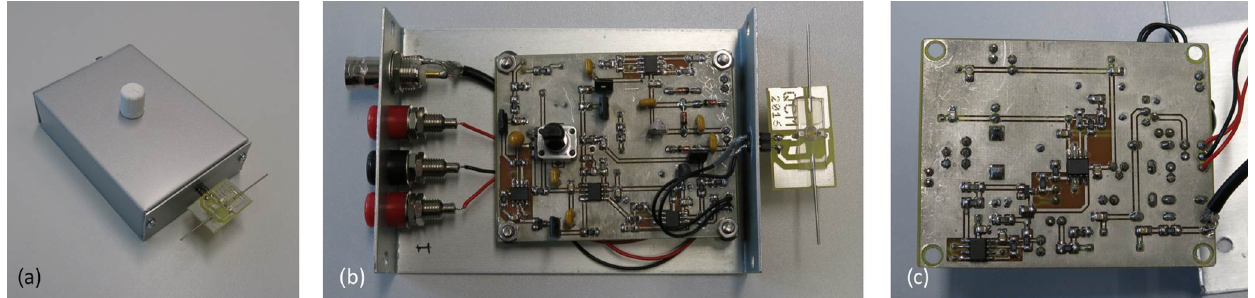
Figure 9. The SMD board (53mm × 66mm) of the circuits shown in Figs. 7 and 8: (a) shielded housing with attached QCM device, (b) upper, and (c) backside of the oscillator circuit board. The knob is connected to P 1 and is used to set the reference value of the amplitude of the